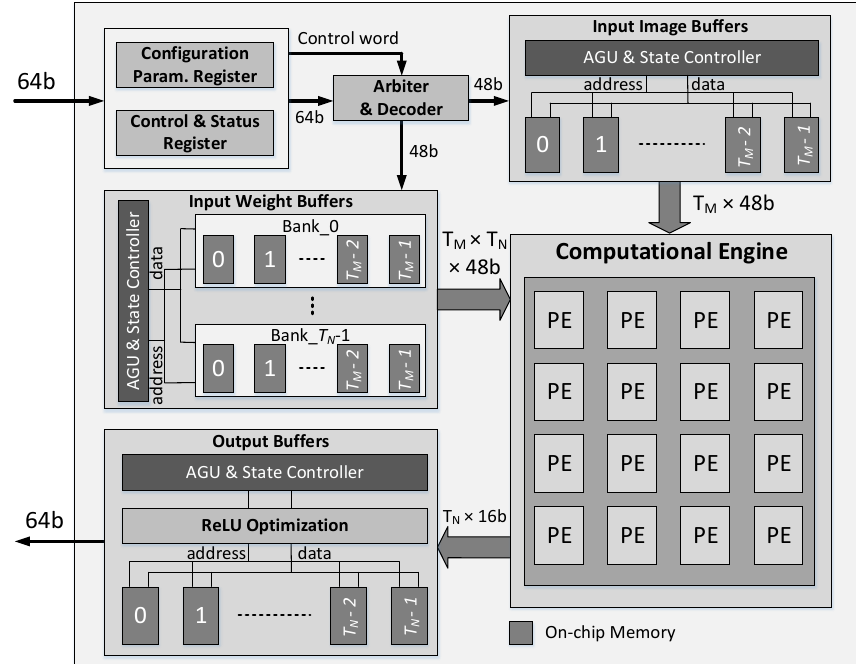
Figure 5. Architecture overview.